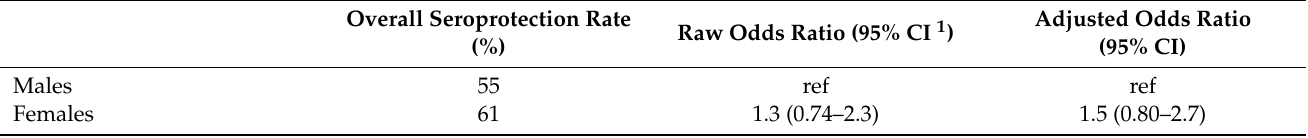
Table 3. Seroprotection rates and predictors for overall seroprotection 4 months after enrollment